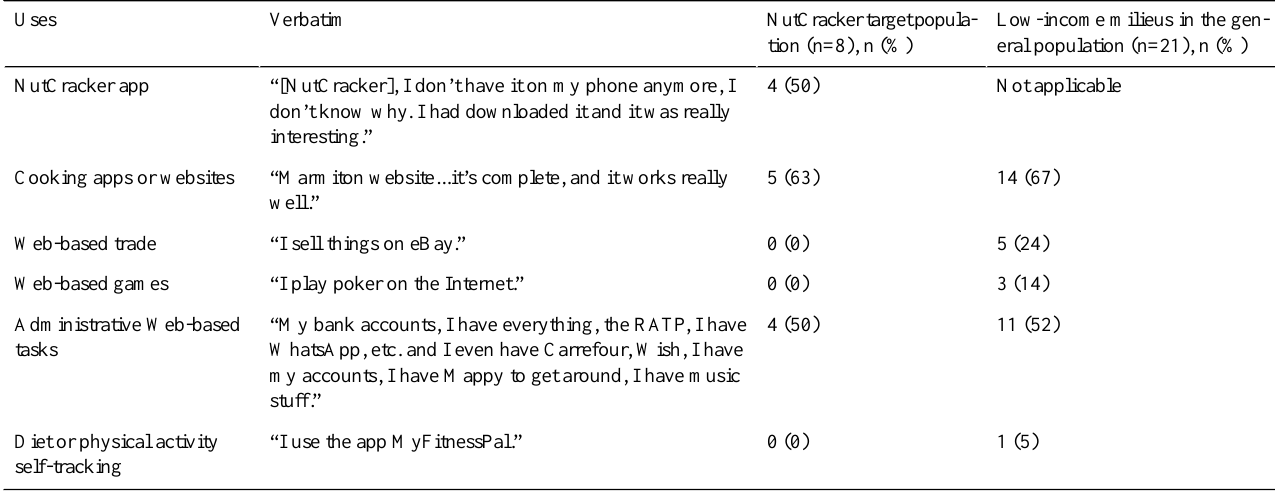
Table 2. Uses of NutCracker and new technologies by the NutCracker sample and the low-income milieu population.